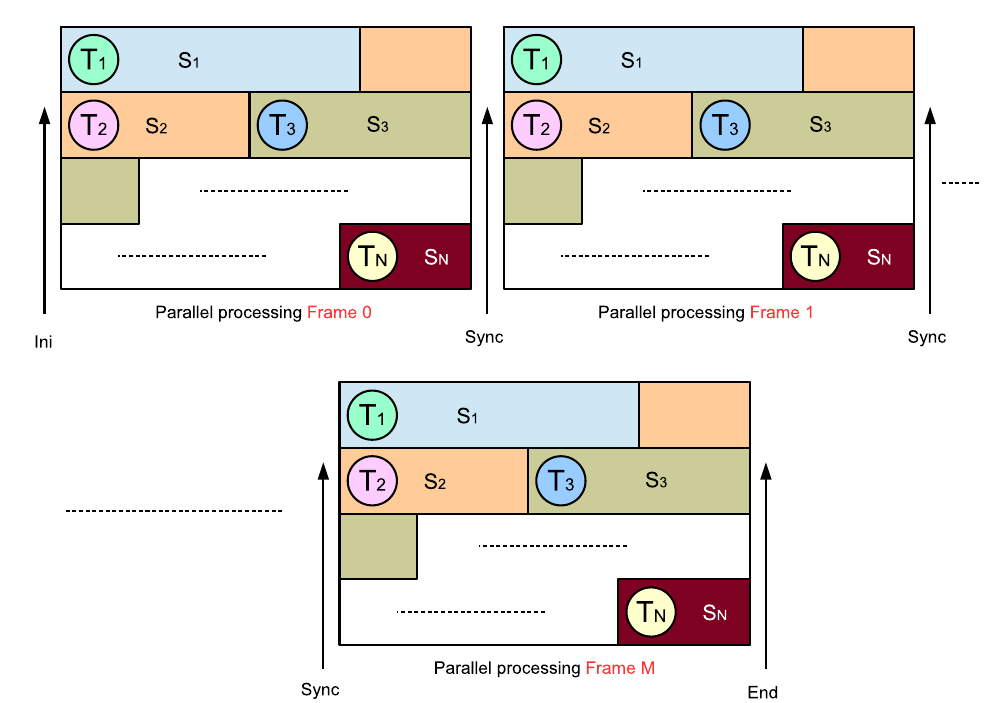
Figure 8. JEM-SP-Sync: Graphical scheme of the slice-based synchronous parallel